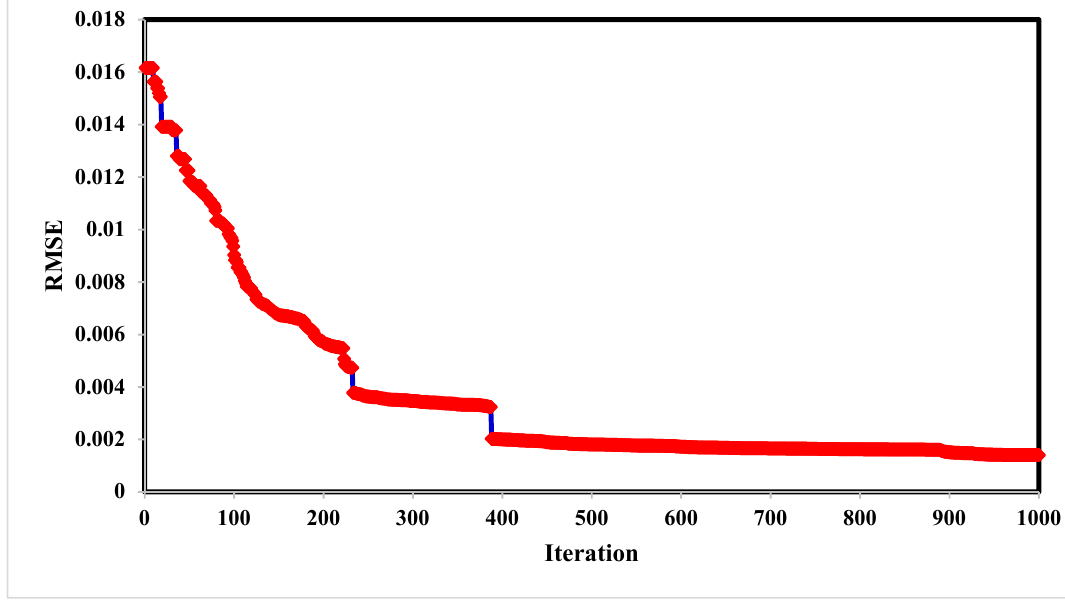
Figure 3. Root mean square errors versus the number of iterations.